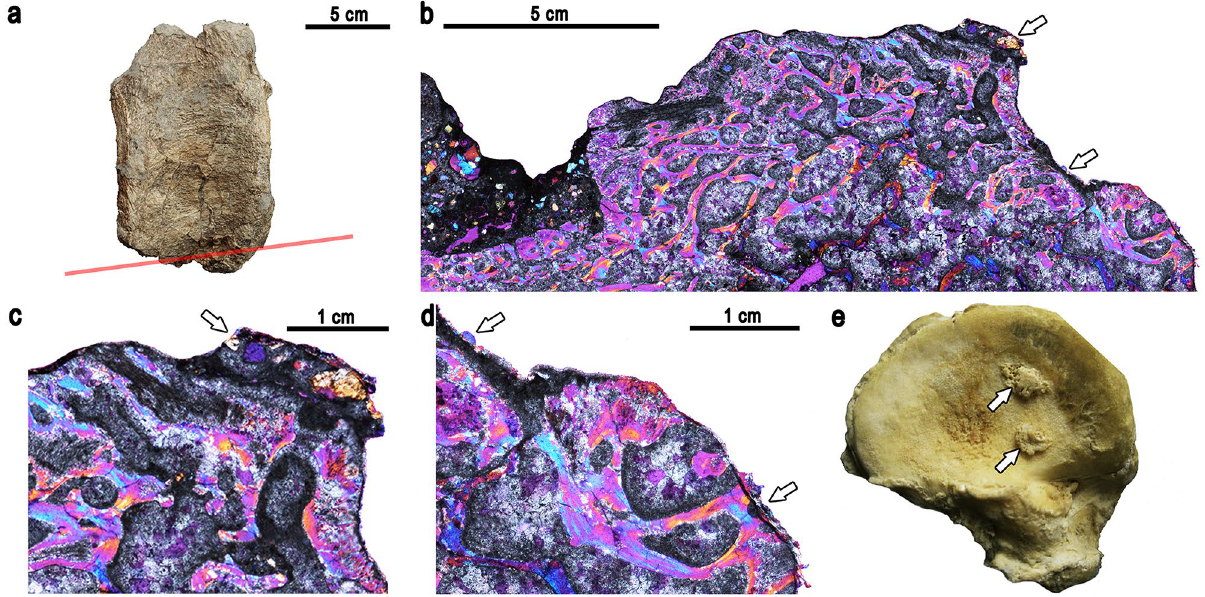
Figure 4. Calcium pyrophosphate deposition. ( a ) Pathological middle caudal vertebra with marked sectioned place. ( b ) The thin section under polarized light with gypsum wedge. ( c , d ) Close up of the pleiomorphic crystals under polarized light with gypsum wedge. ( e ) en face view of glenoid surface of scapula from # 2643 from Hamann-Todd human skeletal collection (Cleveland Museum of Natural History, Cleveland, Ohio, USA). Arrows are pointing at the calcium pyrophosphate